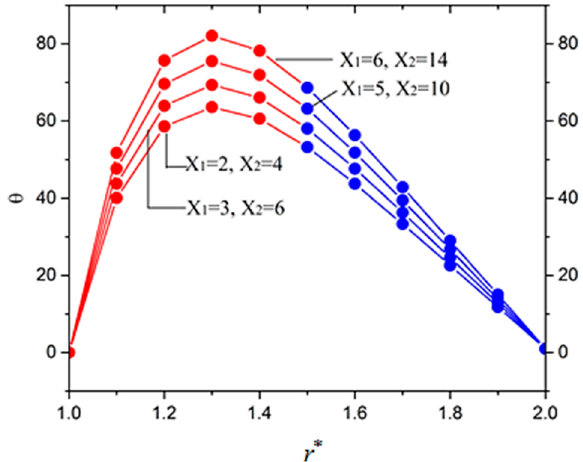
and ε D 2 on temperature Br 2 = 0.5 X 1 = 0.5, X 1 = 1.0, δ = 2. Coatings 2018 , 8 , x FOR PEER REVIEW 2 1